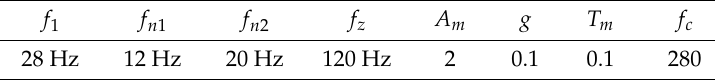
Table 4. The parameters of the simulation signal.